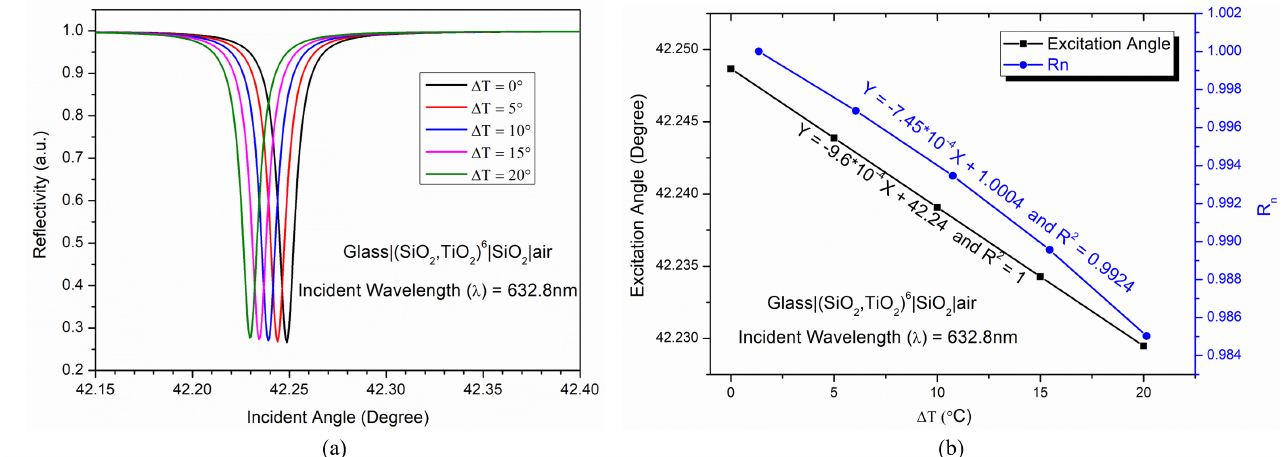
Figure 4. Effect of varying temperature on ( a ) Reflection spectrum of Glass|(SiO 2 ,TiO 2 ) 6 |SiO 2 |air structure, and ( b ) Excitation angle and normalized reflectivity for an incident wavelength of 632.8